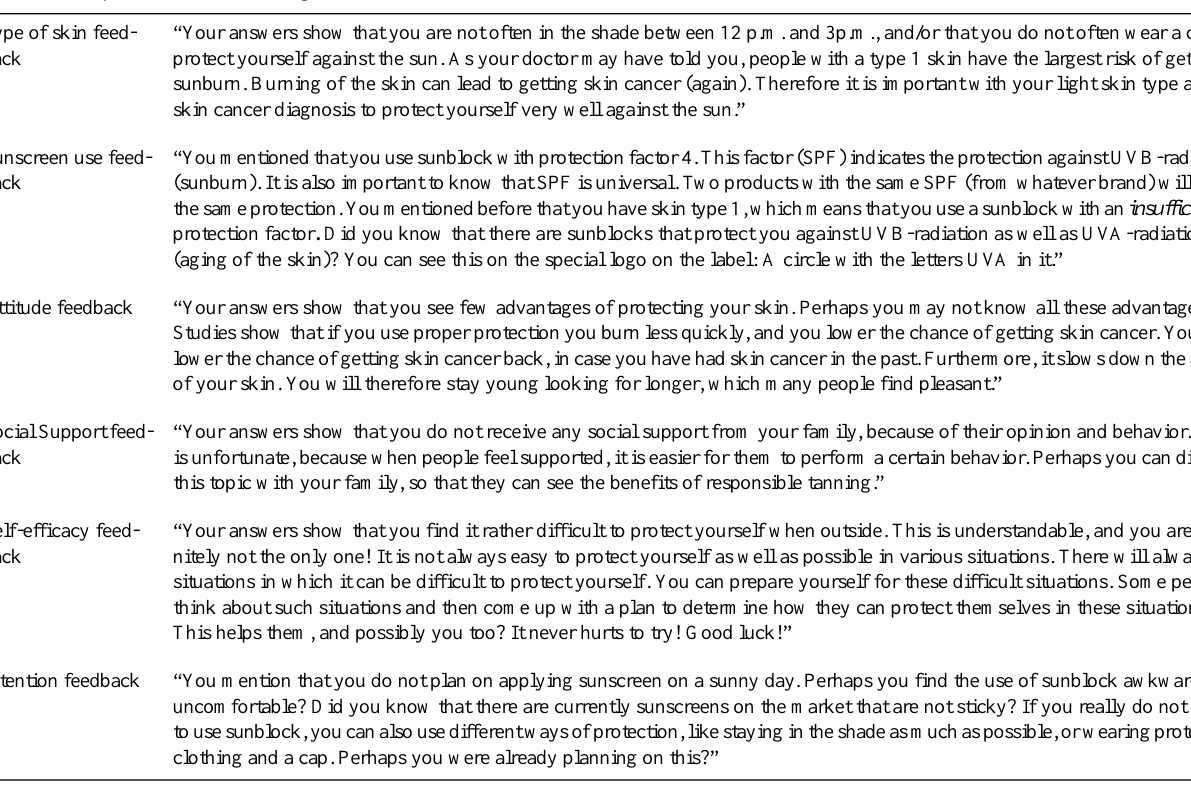
Table 1. Examples of feedback